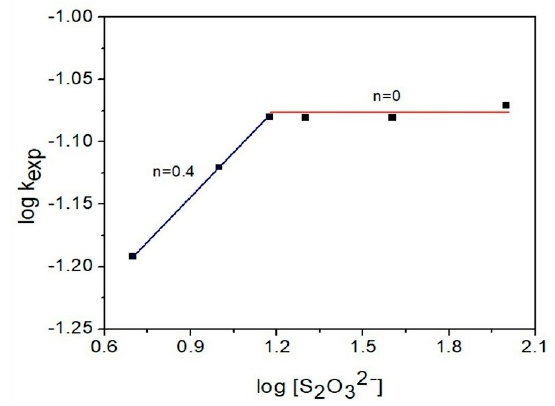
Figure 9. k exp dependence vs. [S 2 O 32 − ]. Reaction order in the concentration range of 0.02 to 0.06 mol · L − 1 (V = 0.5 L, 40 g · L − 1 Mineral, PO 2 = 1 atm, pH = 10, leaching time = 240 min, [Cu 2+ ] = 0.006 mol · L − 1 , 298 K (25 ◦ C), RPM = 750 min − 1 ).